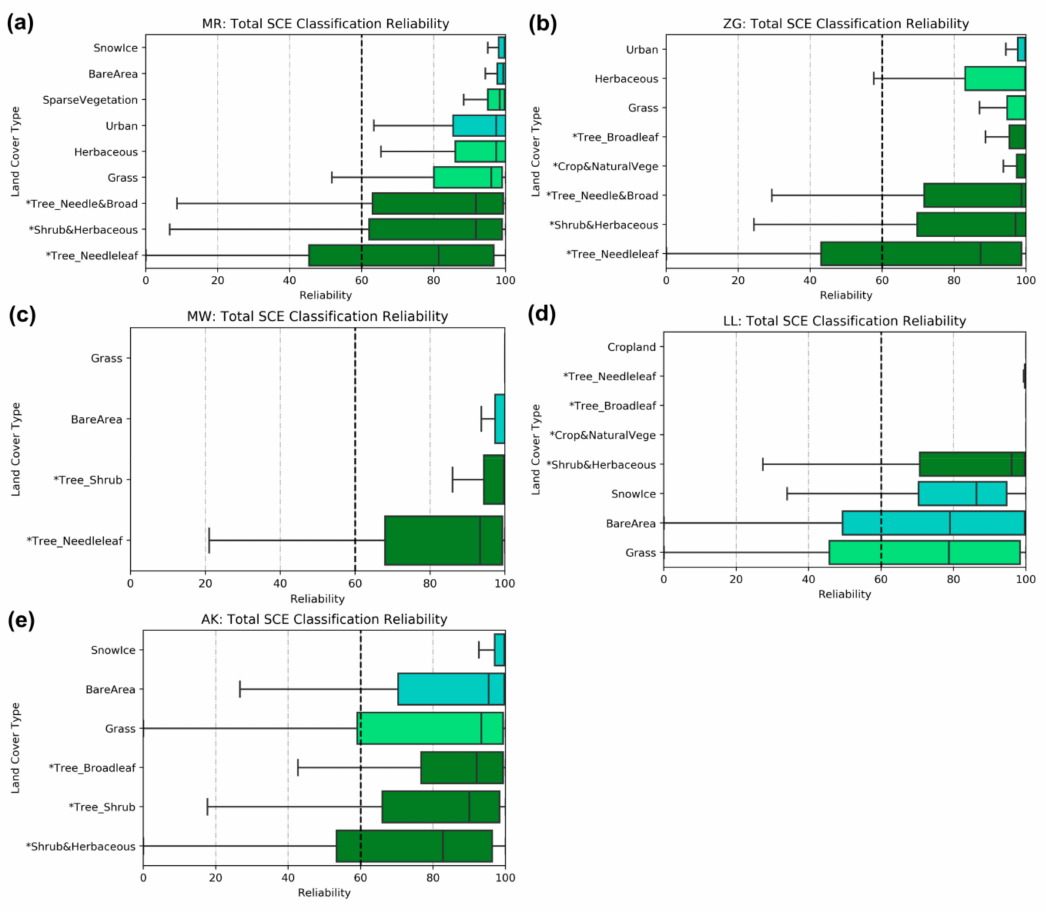
Figure 9. Assessment of the relationship between reliability and land cover class in each region: ( a ) Monte Rosa (MR); ( b ) Zugspitze (ZG); ( c ) Mount Whitney (MW); ( d ) Landtang Lirung (LL); and ( e ) Aoraki (AK). Densely, lightly, and non-vegetated land cover classes are colored in deep green, light green, and light blue,